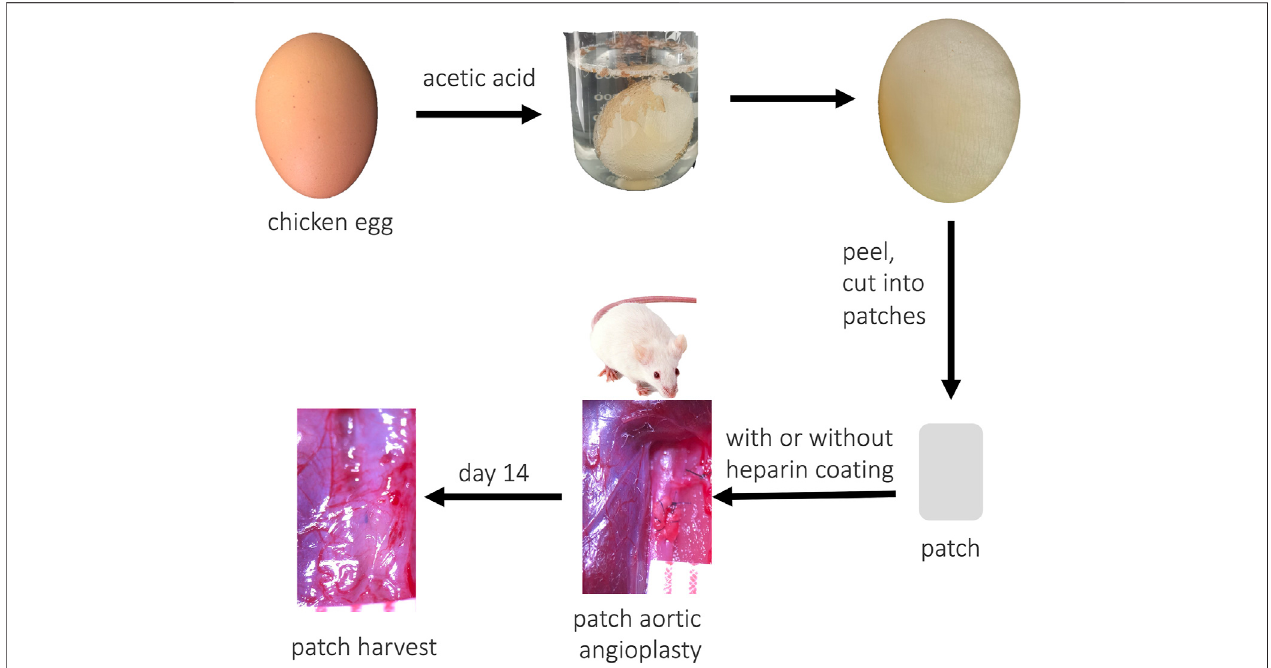
FIGURE 1 | Illustration photograph showing the study